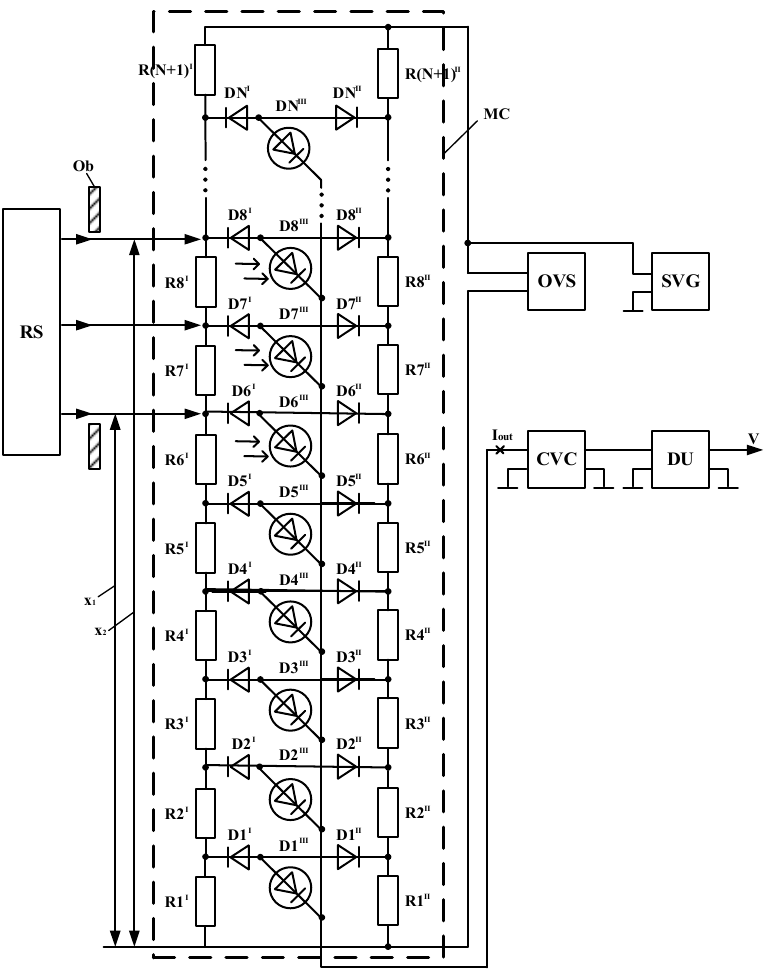
Figure 1. Enabling a multiscan using the “scanistor” scheme in the analogue mode. Real MS is not an ideal device. There is a limited slope of switching of real I-V char- acteristics of photodiode cells, which determines the width of the volt-scanning aperture, equal to the quadruple temperature potential, E 0 [12]. The formation of the MS output current I out at the input of a current-to-voltage converter (CVC) is performed by the pro- gressive switching of photodiodes by a sawtooth scanning voltage taking into account the volt aperture of photodiode cells. At the differentiation of the voltage from the CVC output by a differentiating unit (DU), due to the smearing of the transitional section of the I-